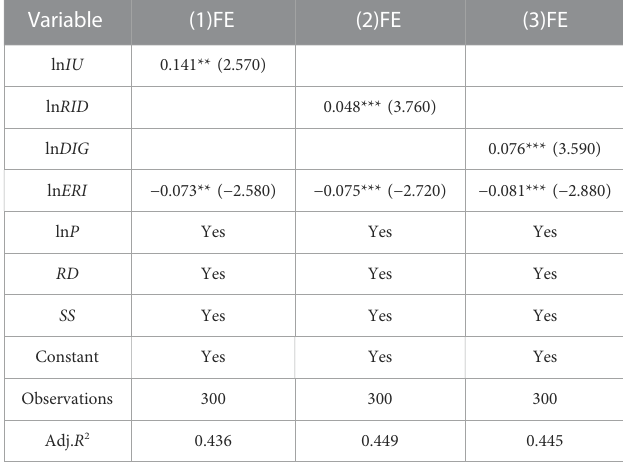
TABLE 6 Robustness test 1: Replace core independent